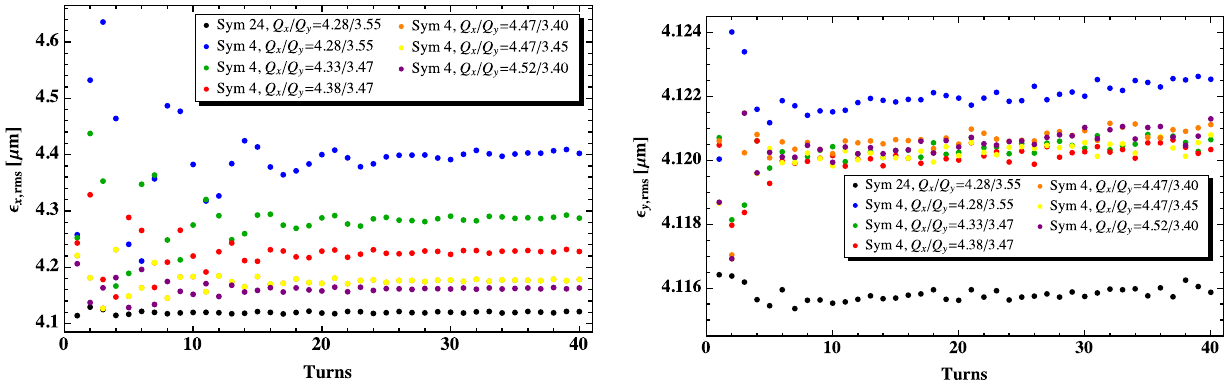
FIG. 21. Time evolution over the first 40 turns of the horizontal (left) and vertical (right) rms emittance for the regular 24-cell FODO lattice (Sym 24) and the 24-cell FODO lattice with 4 × 1 cells straight sections (Sym 4) for different working points. The initial oscillation of the horizontal emittance decreases if the working point is moved away from the integer resonance.